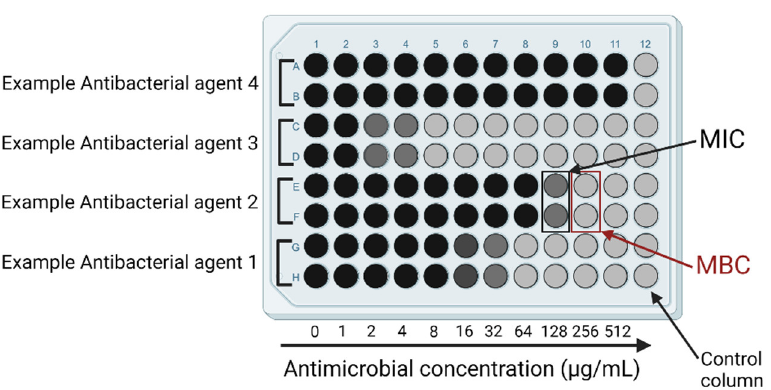
Figure 4. Microdilution method for in vitro evaluation of antimicrobial activity. Figure created with Biorender.com.